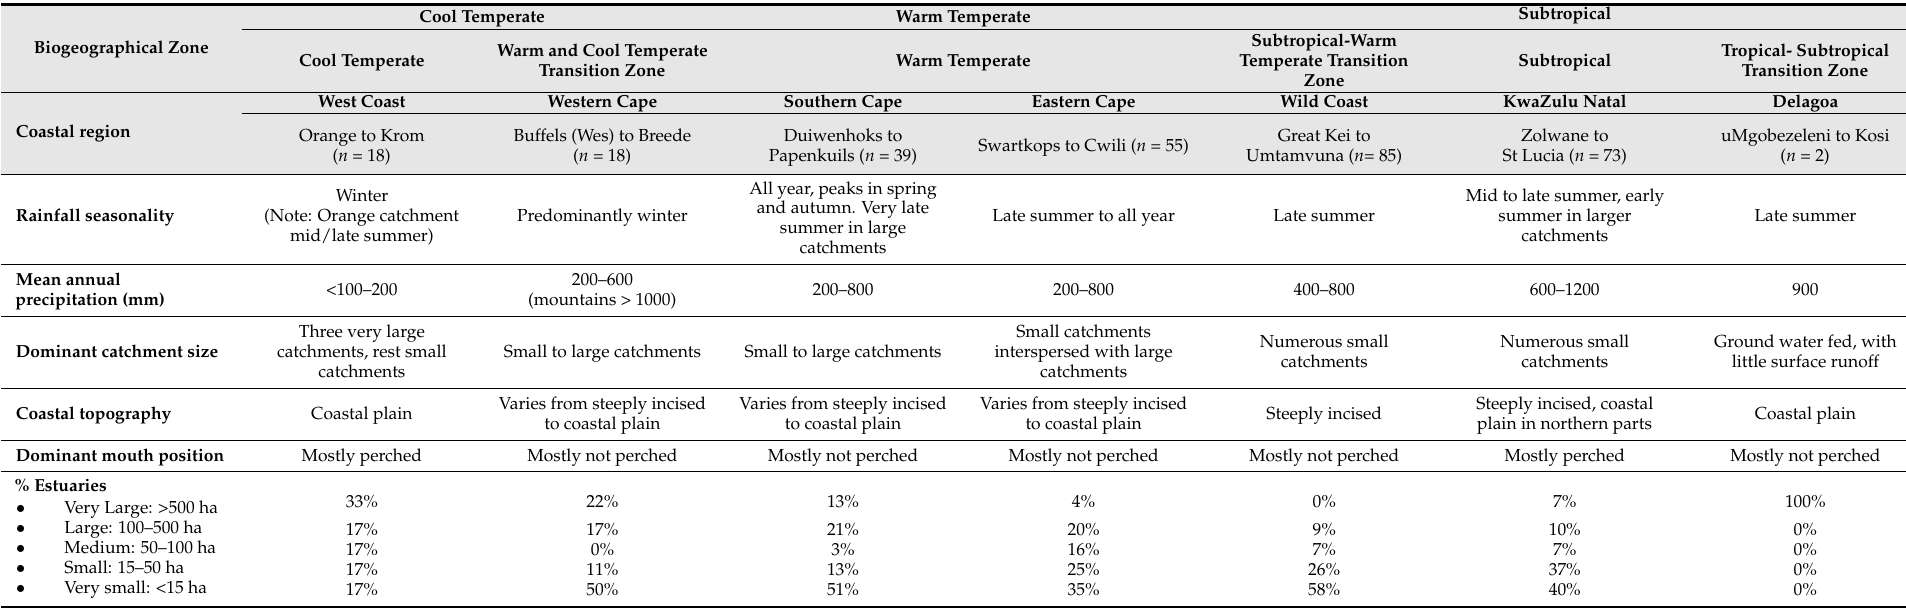
Table 2. Summary of the climatic, oceanic, and estuarine characteristics typical of the seven coastal